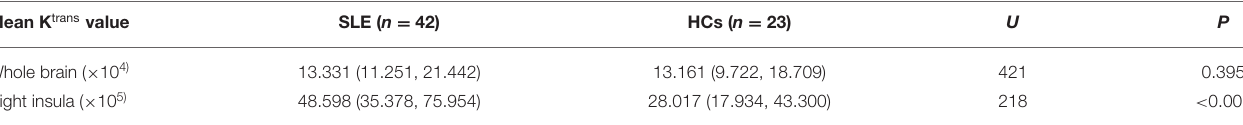
TABLE 3 | The mean K trans value of SLE and HC groups.